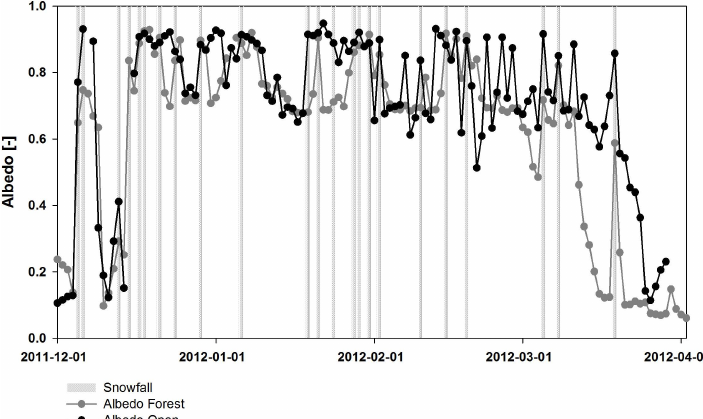
Fig. 13. Snow cover albedo under a conifer forest canopy and an open field site during the winter 2011/2012 with snowfall